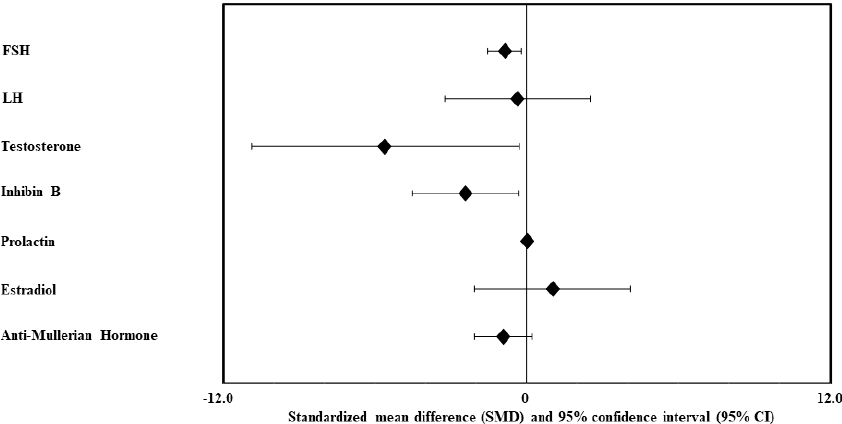
Figure 3. Summary of the Zhao and Pang [70] meta-analysis on the effects of metabolic syndrome (MetS) on sexual hormones.